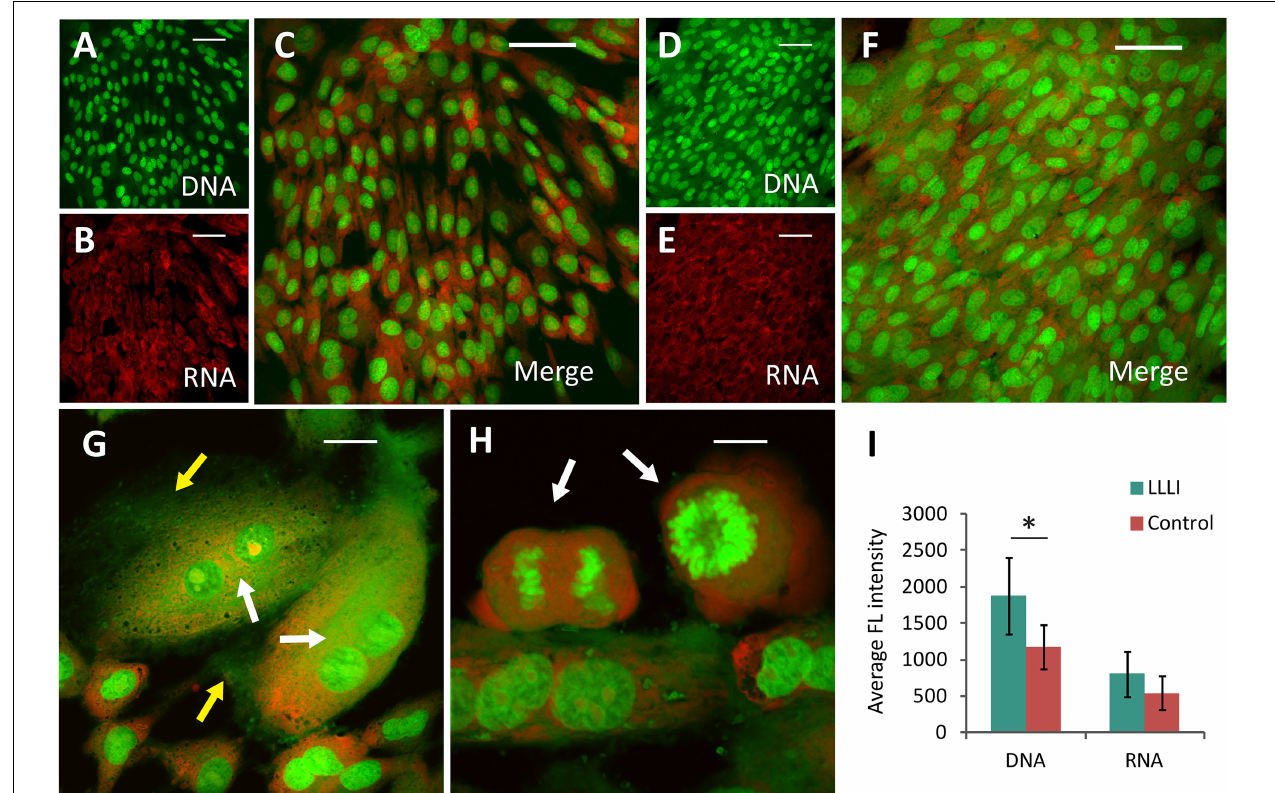
FIGURE 3 | Cytomorphological analysis of cultured rabbit chondrocytes by acridine orange staining and CLSM. The differentially labeled DNA and RNA in cells excite and emit at different wavelengths as fluorescent green and red, respectively. The dual labeling unveils the cells and their relative intensity implicative of cellular activity as DNA is duplicated and RNA synthesized. (A–C) , images of untreated chondrocytes with stained DNA (A) and RNA (B) merged into dual-channel image (C) acquired by CLSM. (D–F) images of chondrocytes treated by LLLI of 5.74 J/cm 2 daily in culture for 6 days, stained for DNA (D) and RNA (E) , and the merged image (F) . (G,H) enhanced anabolic synthesis in LLLI-treated chondrocytes shown as typical multi-shaped cells with double- and poly-nuclei cells. Duplicating and mitotic chromosomes and cell aggregates are indicted by arrows. (I) significant higher levels of DNA (green) and RNA (red) in LLLI-treated chondrocytes than untreated cells as shown by quantification of the dual fluorescent labeling. Scale bar (—) represents 50 µ m. Daily LLLI treatment = 5.74 J/cm 2 of LLLI for 8 min; Error bar = SD; ∗ P <